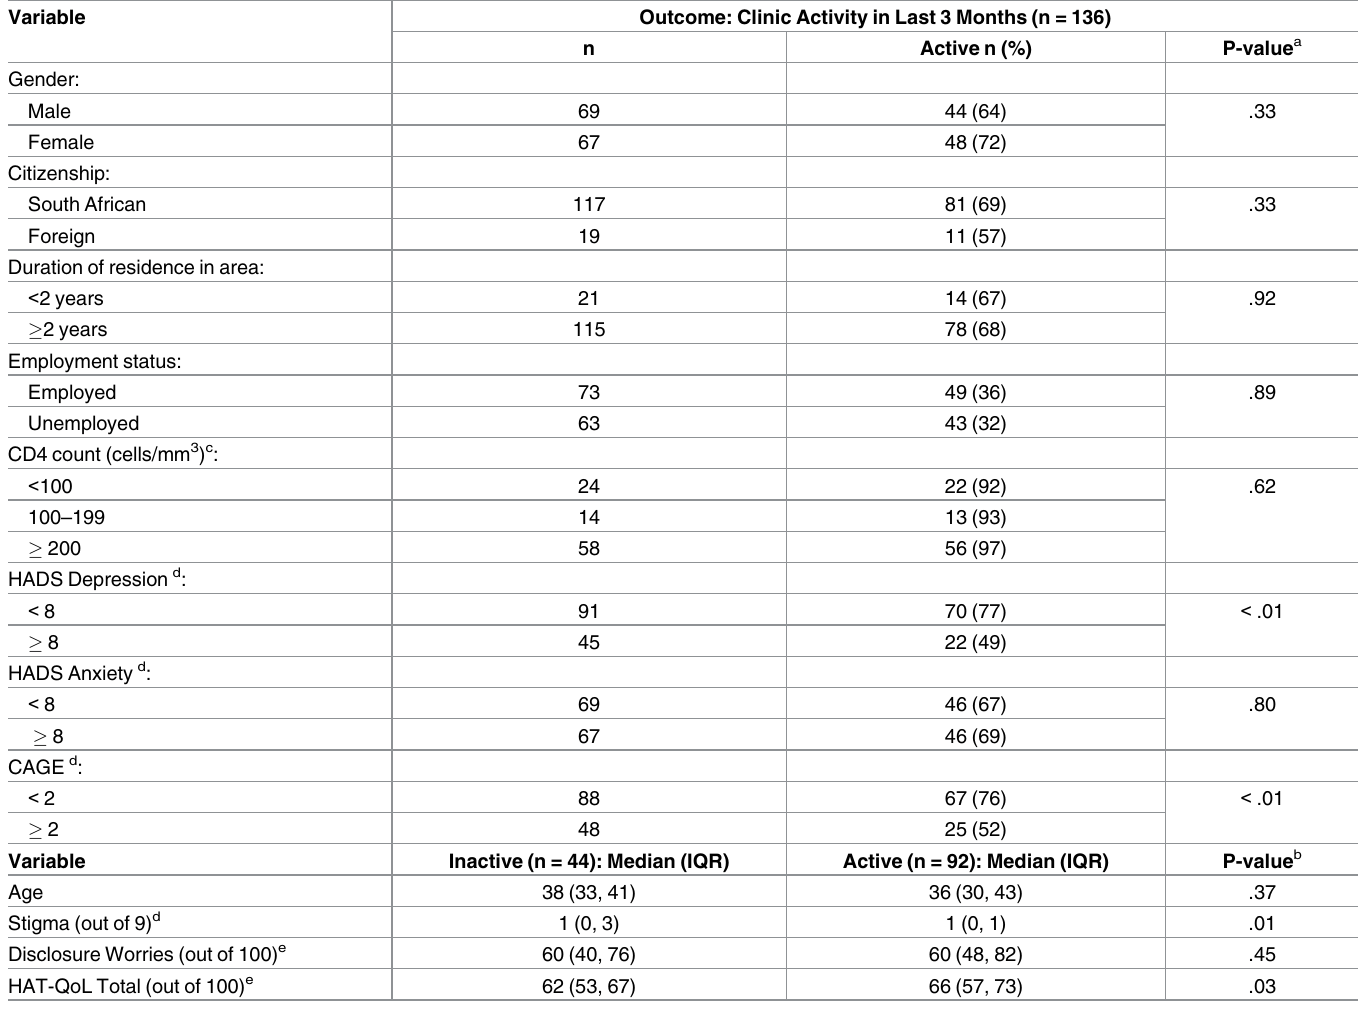
Table 4. Factors associated with retention in care.